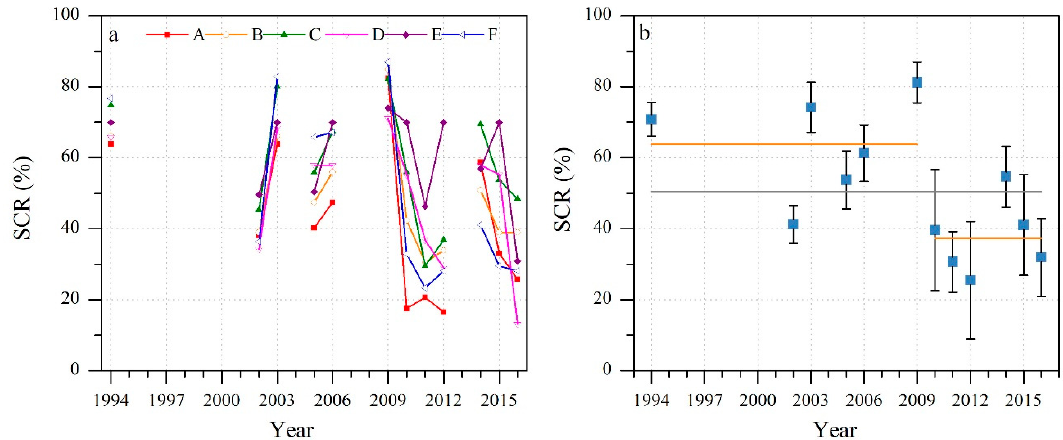
Figure 6. The annual snow-cover ratio (SCR) for individual glaciers (a), and the mean SCR for seven glaciers (b) during the period of 1994 to 2016. The gray solid lines show the average SCR over 1994–2016, and the orange solid lines show the average SCR before and after 2010.